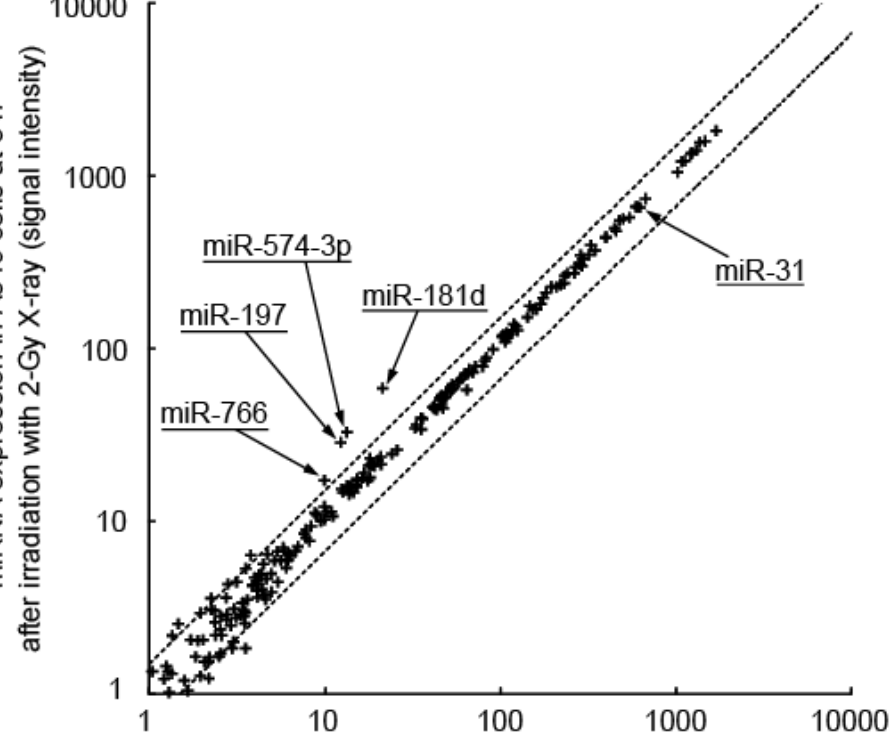
Figure 1. X-ray-responsive miRNA in A549 cells. The expression level of the miRNA in A549 cells after 3 h of irradiation with 2 Gy X-ray was compared with that of the miRNA in non-irradiated cells. The dotted lines indicate a threshold of 1.5-fold